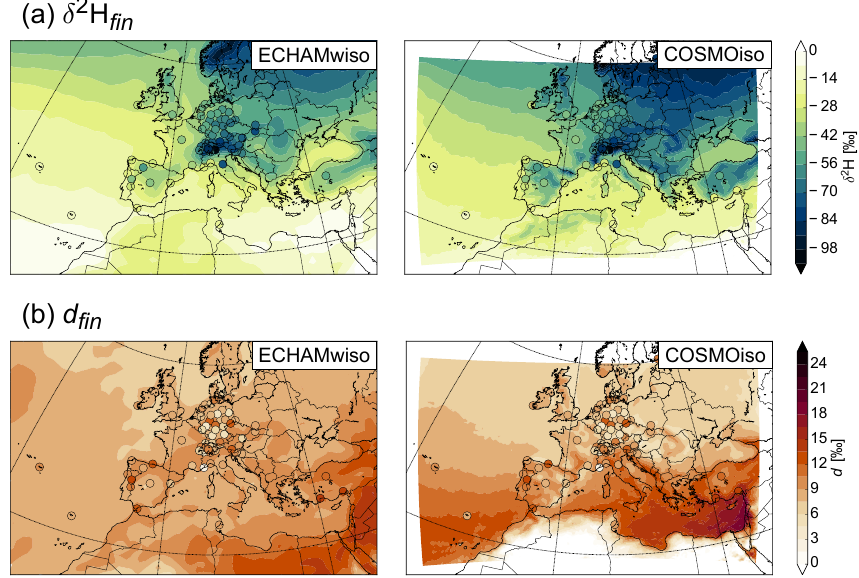
Figure 2. The 30-year mean of (a) δ 2 H and (b) d in precipitation from ECHAMwiso (left) and COSMOiso (right). The GNIP measurements are shown as dots.